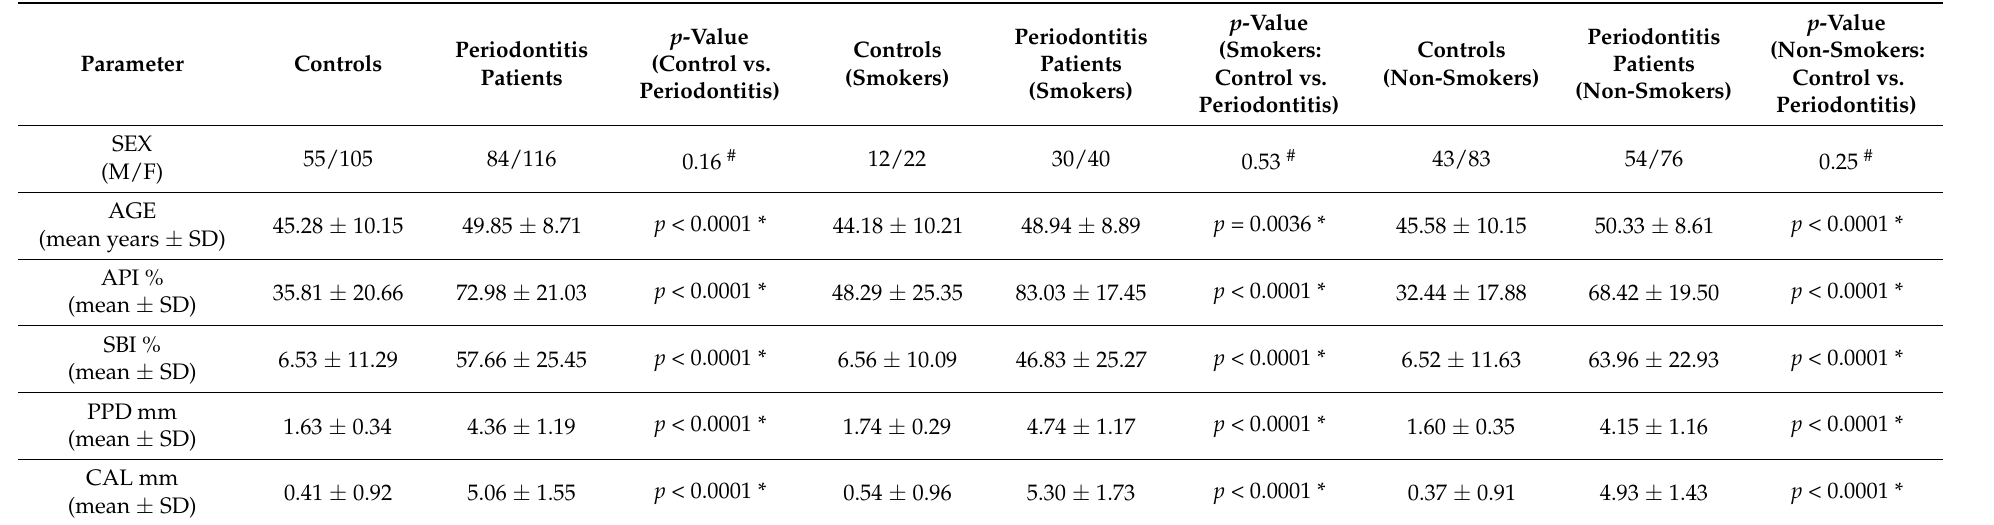
Table 1. The clinical periodontal parameters of studied